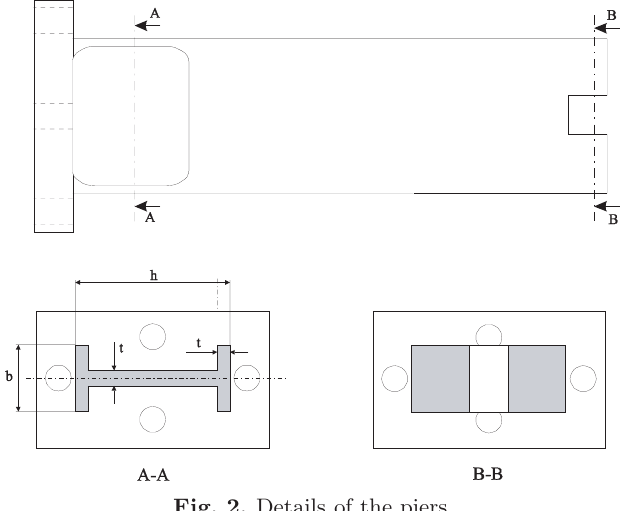
Fig. 2. Details of the